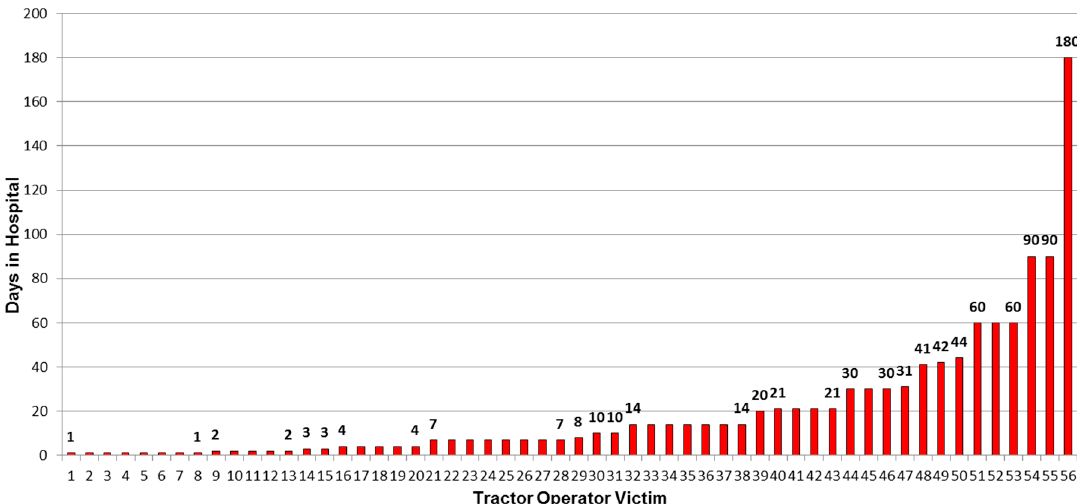
Figure 5. Days in hospital for operators injured as a result of non-ROPS tractor overturns, n = 56.